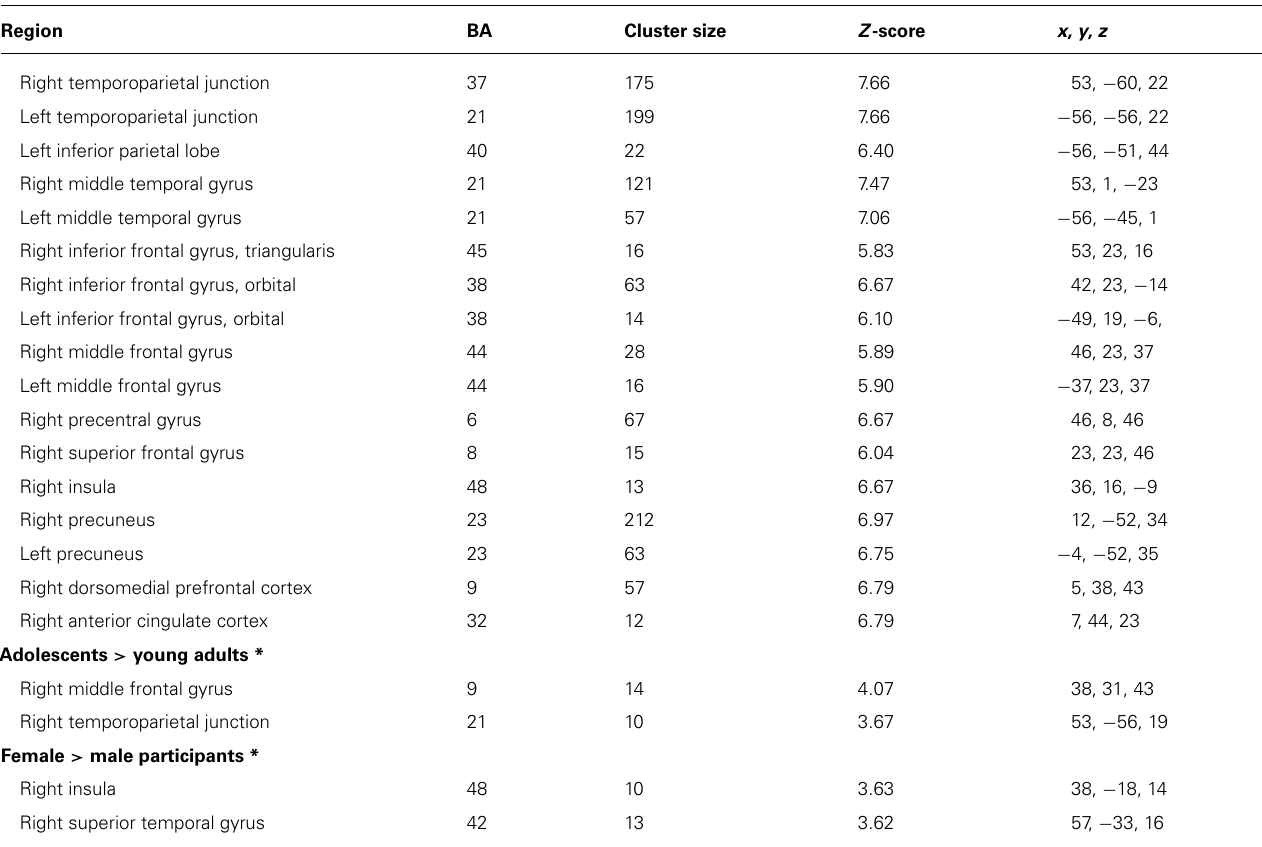
Table 1 | Significant clusters of activation in the whole-brain analysis for the contrast Risk > Ambiguity for all participants ( N = 60) and by age and gender groups (FWE, corrected, p ≤ 0.001; except contrasts marked with symbol * that employed an uncorrected threshold of p ≤ 0.001; extent threshold > 10